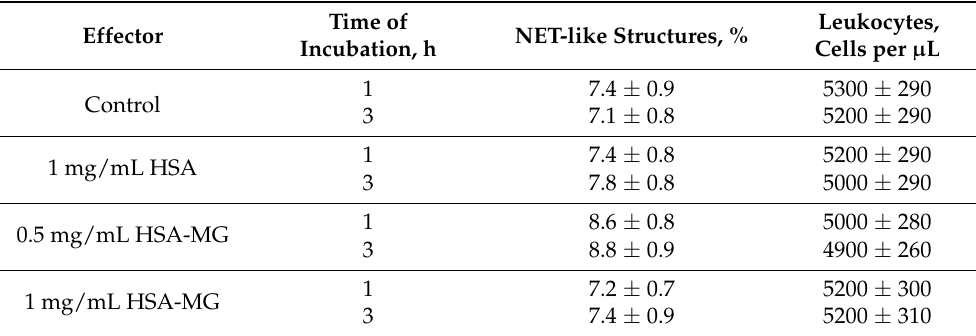
Table 2. Effects of HSA and HSA-MG on leukocyte count and NET-like structure percentage in whole blood after 1 and 3 h incubation.